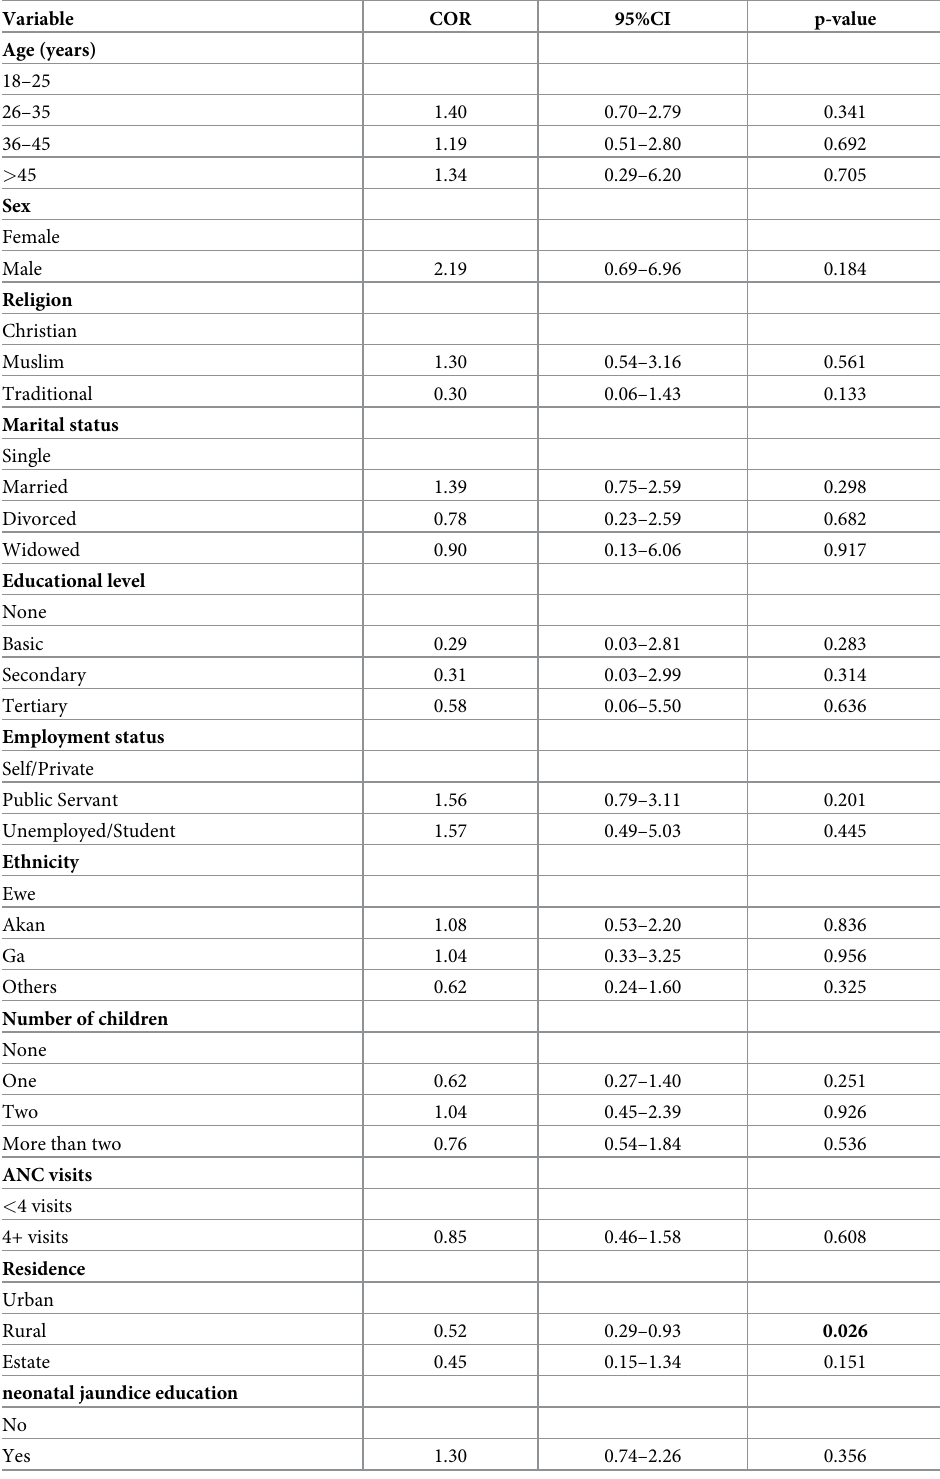
Table 7. Logistic regression results showing factors associated with beliefs and practices of caregivers regarding neonatal